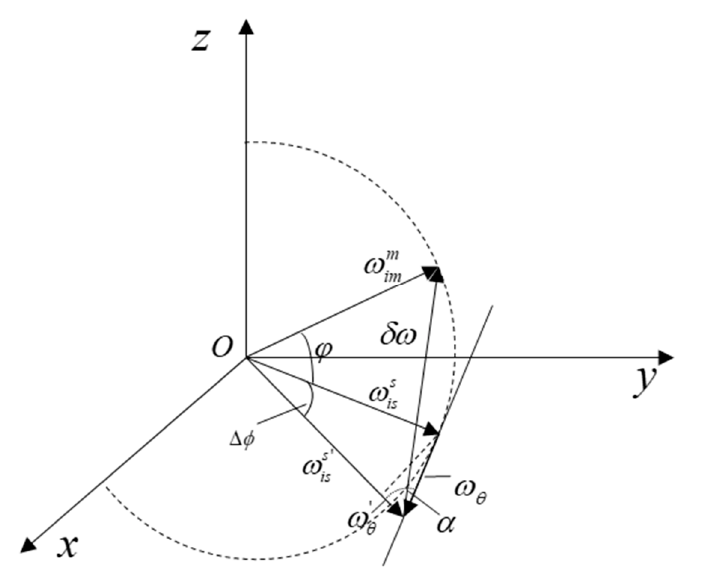
ω and ' s ω . and ω s (cid:48) im is im is